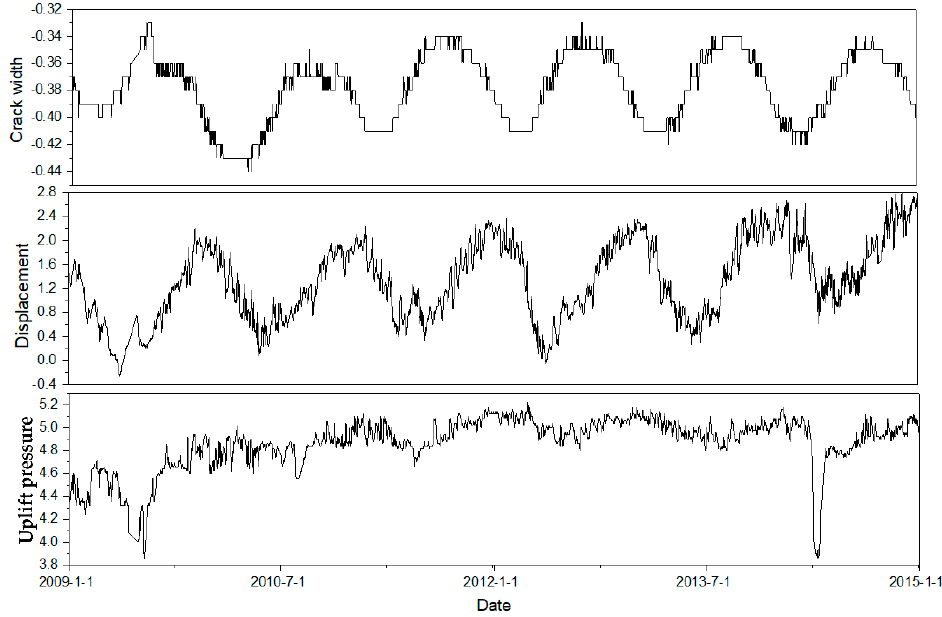
Figure 8. Displacement, seepage, and crack width recorded in the dam section #12.